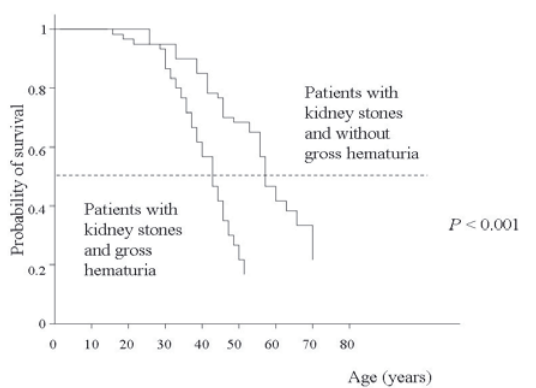
Figure 3. Comparison of renal survival between patients with kidney stones and with and without gross hematuria.